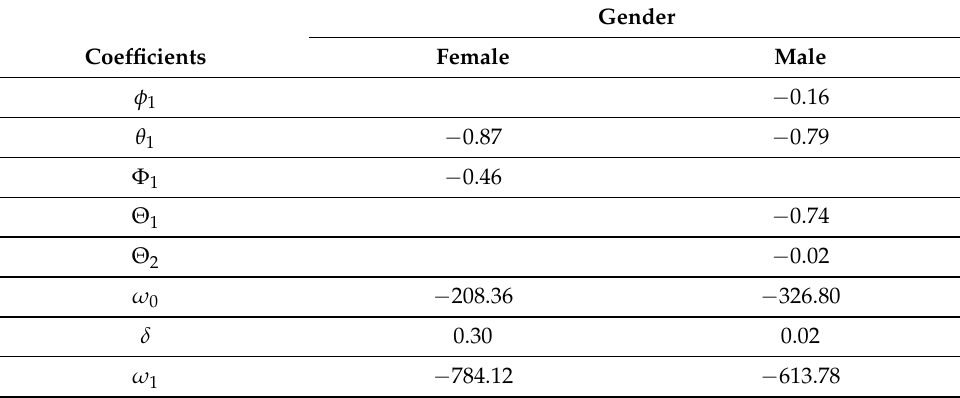
Table A5. ITSA model parameter estimates for